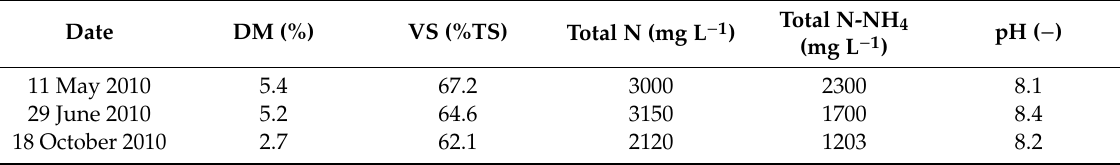
Table 2. Digestate characterization during the experimental